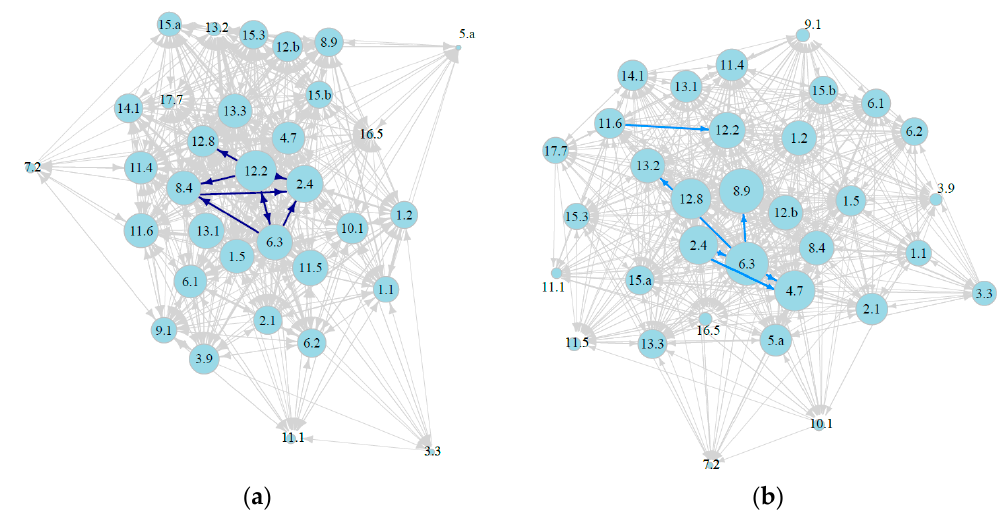
Figure 4. Bidirectional unimodal network of: ( a ) Positive reinforcing interactions (+2) between the targets considered priority by wetland researchers. Nodes are targets (light blue) and interactions the reinforcing linkages between targets (grey arrows). For visualization purposes, interactions existing in more than 8 surveys (4 standard deviations) are highlighted in dark blue. Node size depends on out-degree or influence of the target on other targets. ( b ) Positive enhancing interactions (+1) between the targets, but only highlighting the most important interactions (sky blue), in same way as in ( a ).